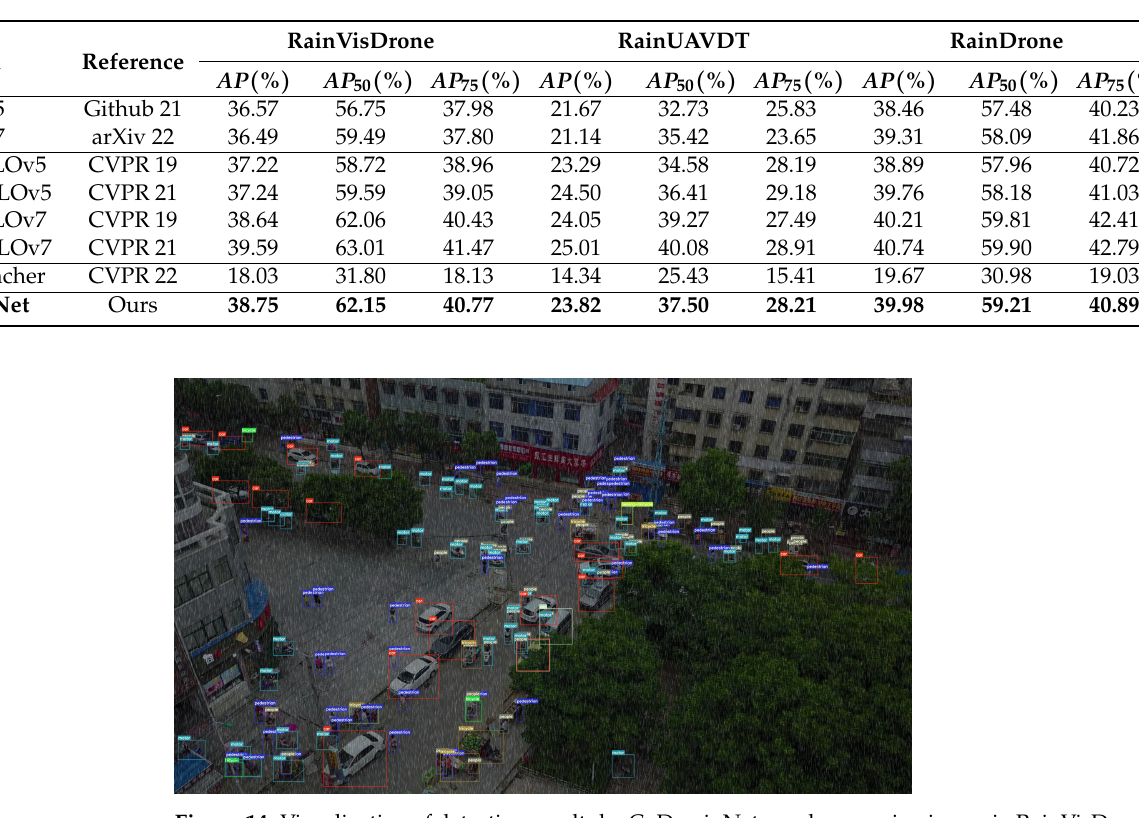
Table 5. Comparison of CoDerainNet with SOTA detectors on RainVisDrone, RainUVADT, and RainDrone datasets.